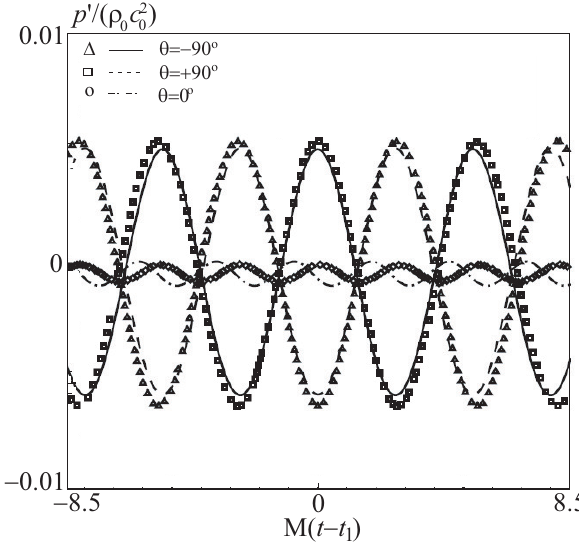
Figure 3. Change in pressure over time for Re =